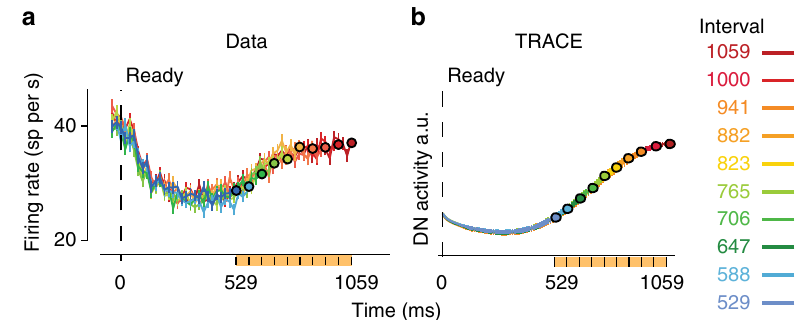
Fig. 6 Comparison of TRACE with electrophysiology data. a Physiology. Activity in the lateral intraparietal (LIP) area of monkeys performing the RSG task is modulated nonlinearly during the range of the prior (orange) between 529 and 1059 ms. The data adapted from previous work 23 . b The corresponding prediction from TRACE. The output of TRACE is shown with arbitrary units. Error bars indicate SEM. Note that the early modulation of LIP activity near the time of Ready , which is absent in TRACE, is due to the presentation of a visual stimulus in the response fi eld of LIP neurons before the presentation of Ready . The relevant region of comparison between the two panels is within the domain of the